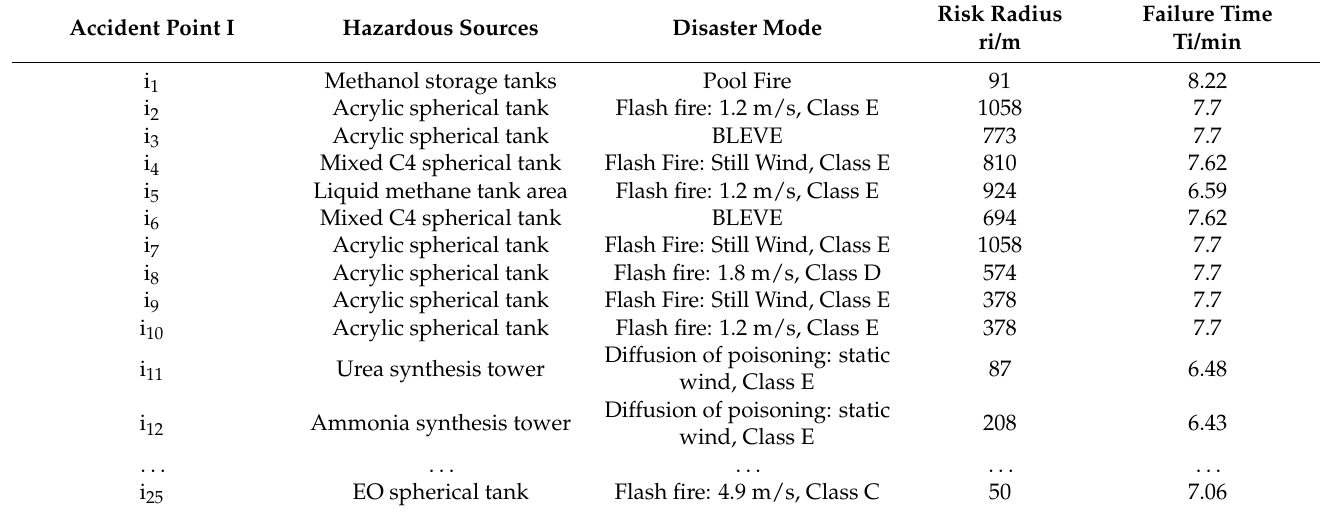
Table 2. Identification of the hazard sources at each emergency accident